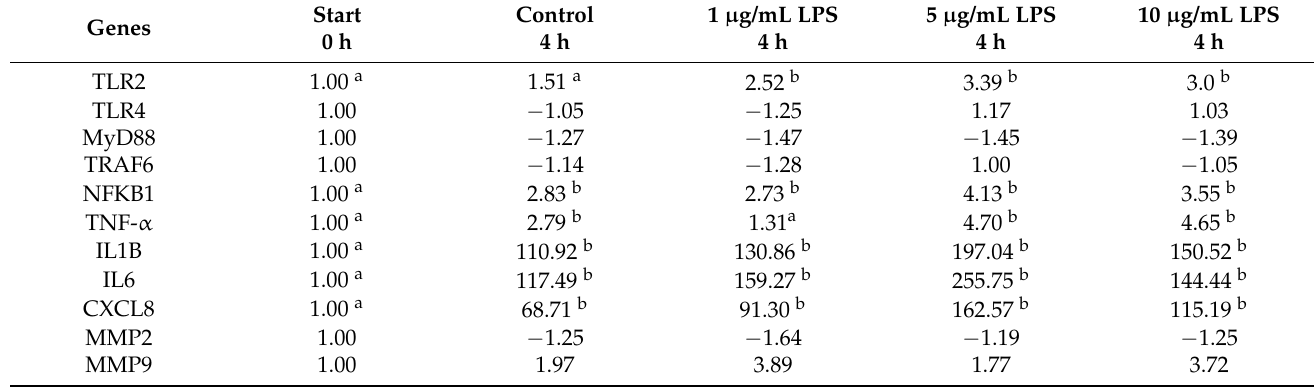
− 1.25 a,b Means without a common superscript indicate significant differences ( p <